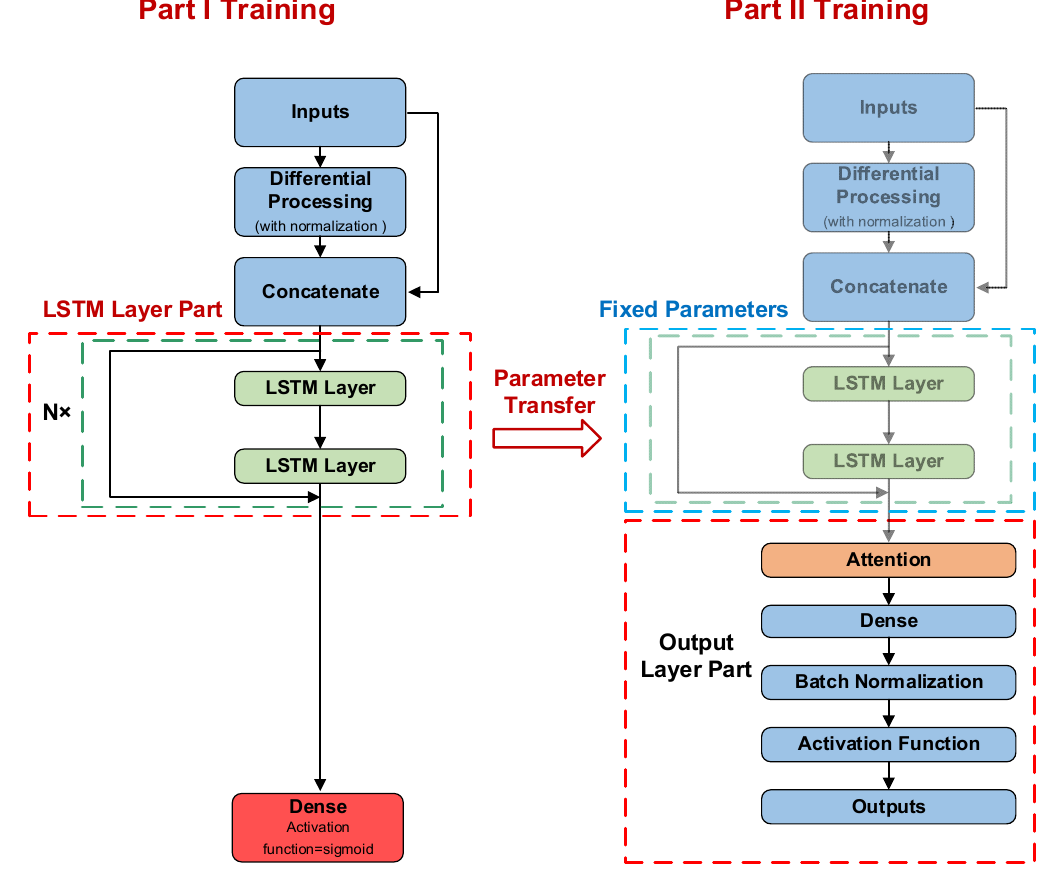
Figure 8. Segmented training diagram. The red box in the figure indicates the position of parameter updates in each training segment. The blue box indicates the positions where the parameters are fixed.